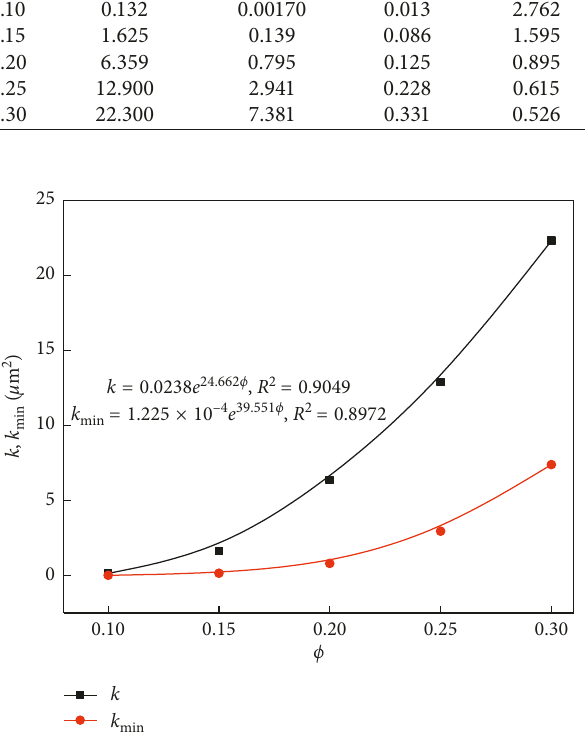
Figure 8: The variation of the permeability k and the minimum with the variation of the porosity. permeability ratio k min